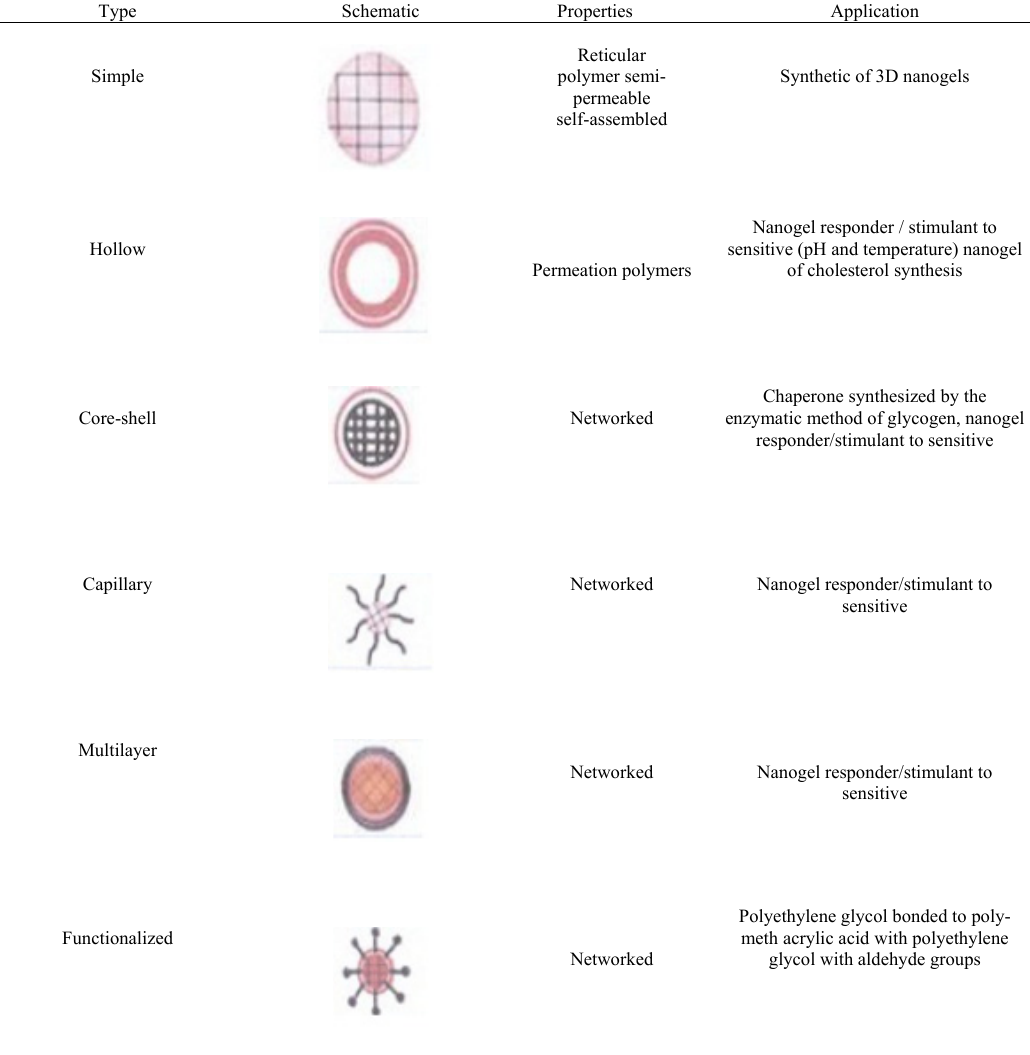
Table 1. A summary of the types of nanogels, their characteristics and their applications.